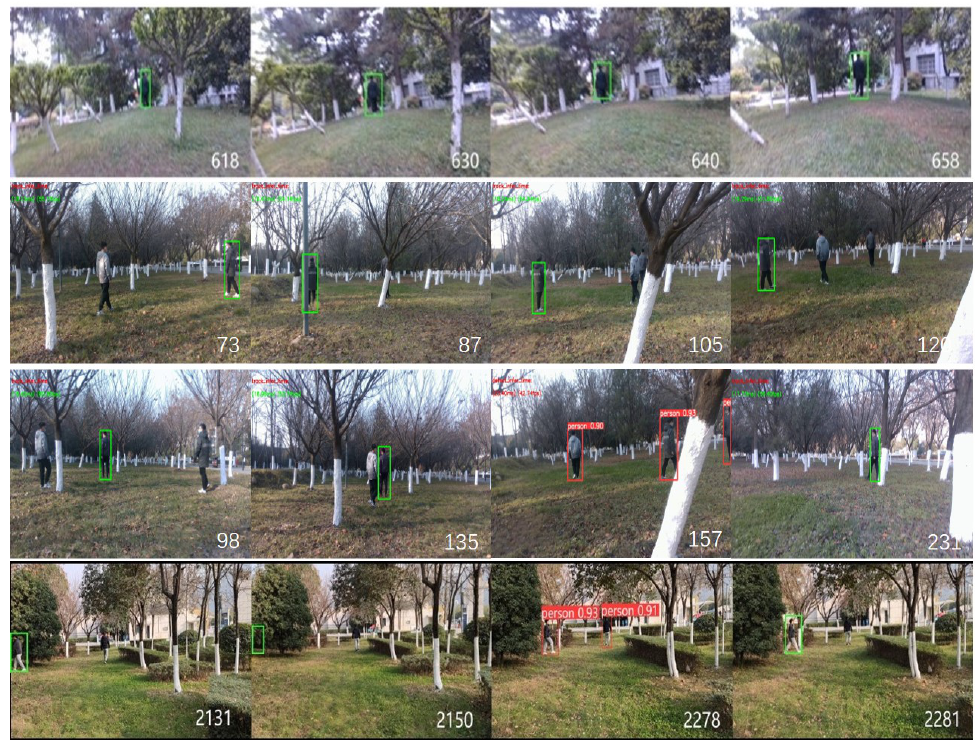
Figure 12. Some running results of the DTE-tracker algorithm (from top to bottom are sequence